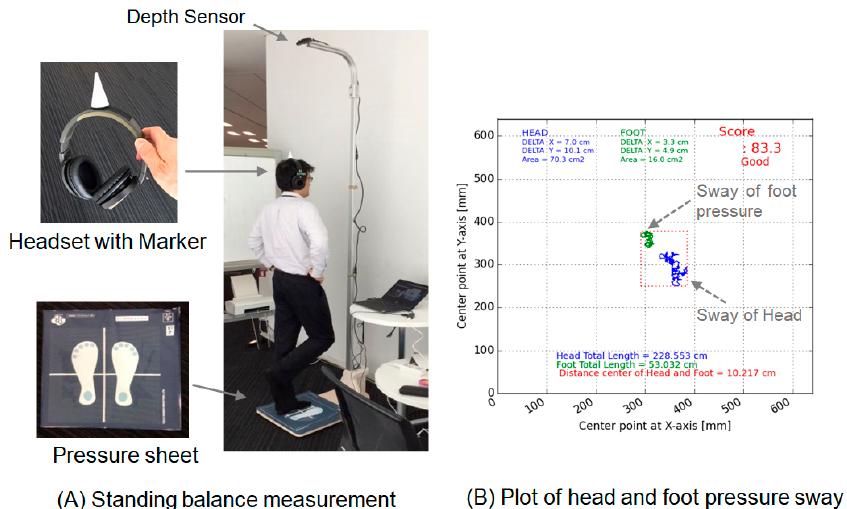
Figure 1. Head and foot pressure sway test. ( A ) Wearing a headset with a marker, the participant stood on the footprint for 30 s. Head and foot sway was measured with his/her eyes open or closed. A representative result of the one-leg standing test is shown. ( B ) Visualization of head and foot pressure sway by plotting is shown.